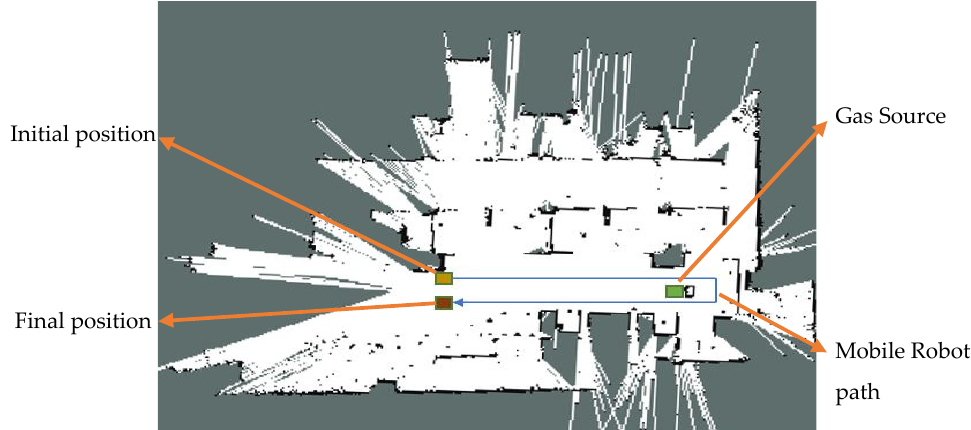
Figure 6. Experimental setup of indoor Lab location.